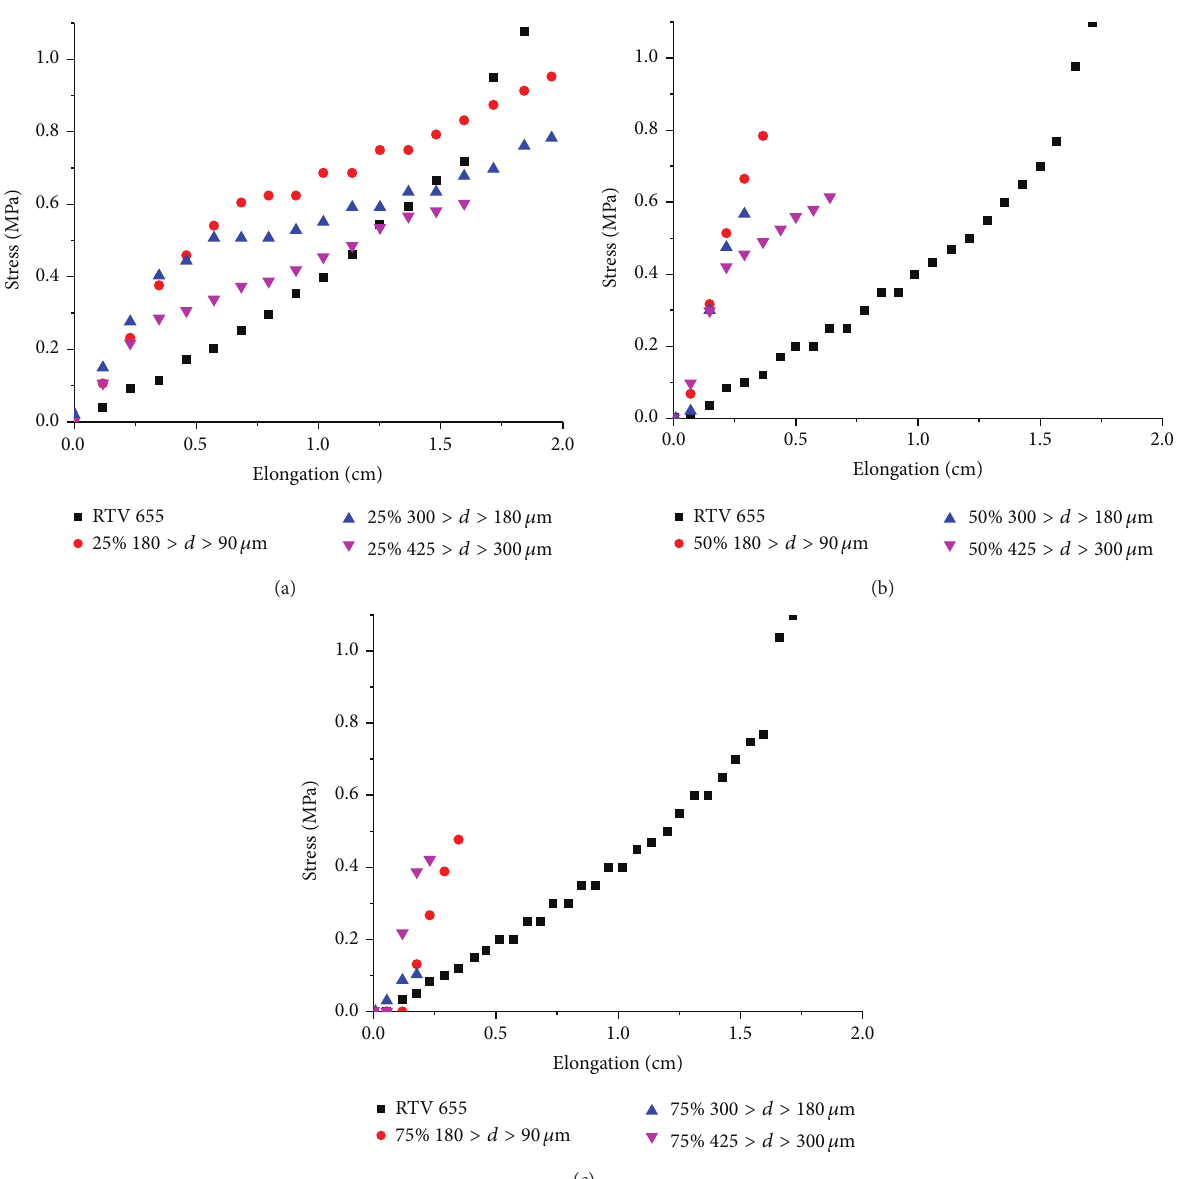
Figure 7: Effect of PCSA particle size and concentration on the stress-elongation behavior of the compound material at room temperature. At 25% IL (a) shows a modest deviation from elastomeric behavior in comparison to neat RTV 655. For 50% IL (b) the compound material shows sign of a stiff material while at 75% IL (c) characteristics of a stiff and strong and more brittle material become apparent. The effect of the particle sizes seems less significant compared to the